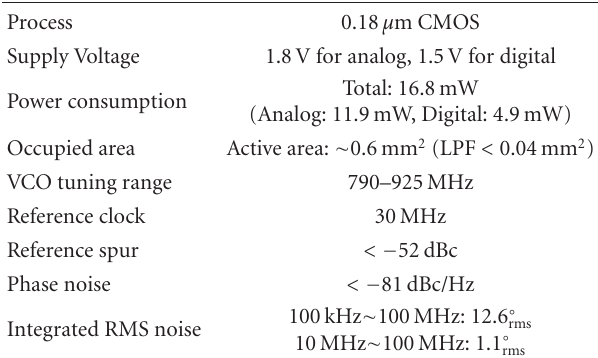
Table 2: Measured performance summary